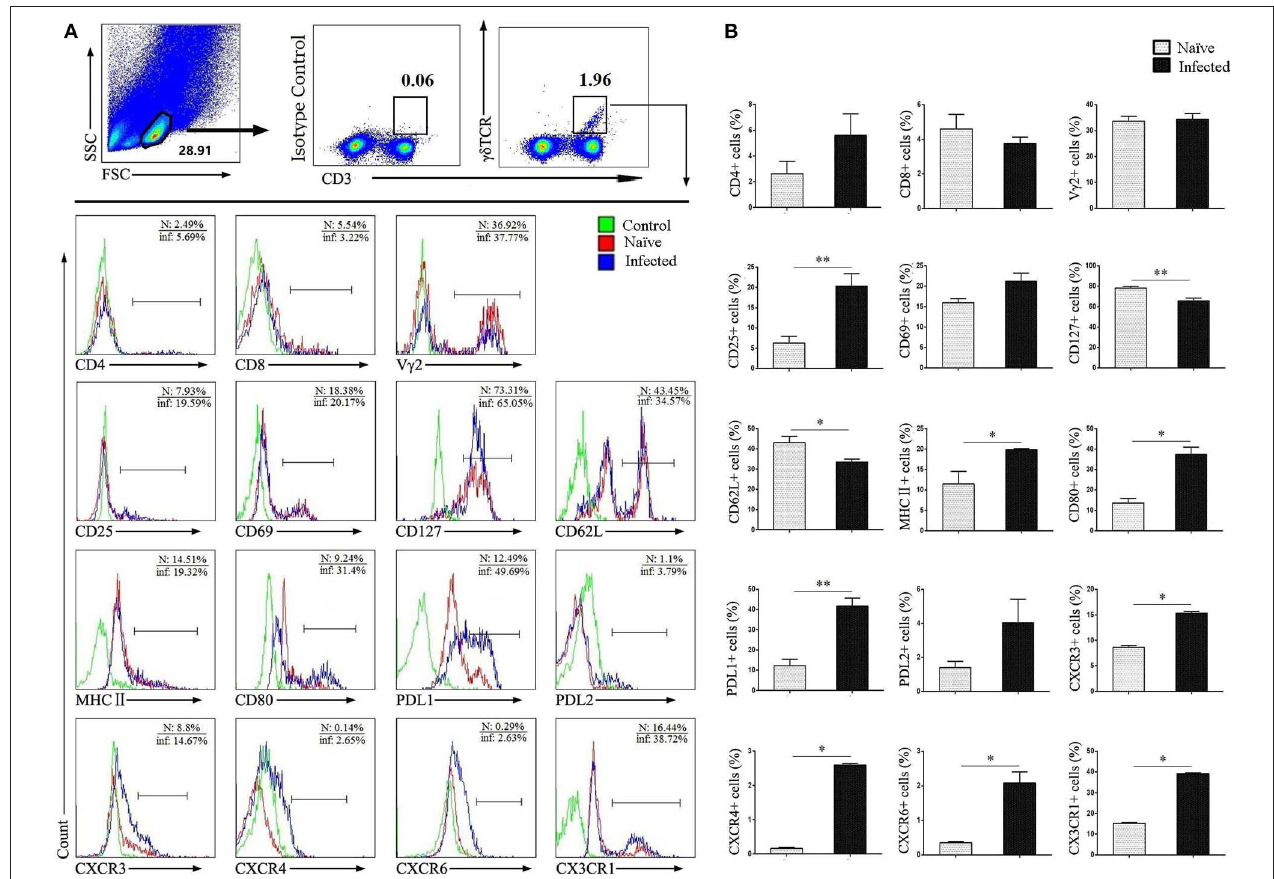
FIGURE 2 | Surface molecule expression on pulmonary γδ T cells. Single lung cell suspensions were separated from naïve and infected mice, and cells were stained with monoclonal antibodies against mice: CD3, γδ TCR, CD4, CD8, V γ 2, CD25, CD69, CD127, CD62L, MHC II, CD80, PDL1, PDL2, CXCR3, CXCR4, CXCR6, and CX3CR1. (A) Representative FACS analysis of three independent experiments is shown. (B) Percentages of surface molecules calculated from FACS analysis, a representative experiment from five independent experiments was shown. The error bars are SD, ** P < 0.01, * P < 0.05.